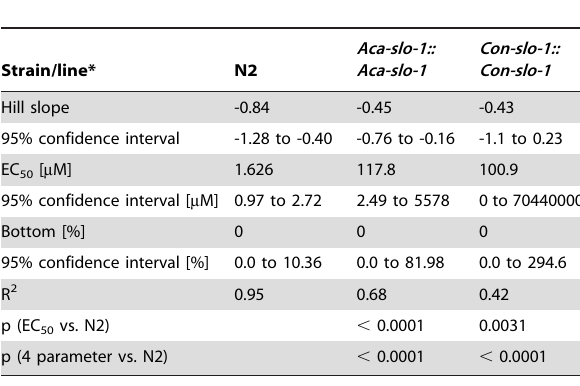
Table 2. Hill slope, EC 50 and bottom value with 95% confidence intervals for transgenic lines expression slo-1 under control of a parasitic nematode-derived